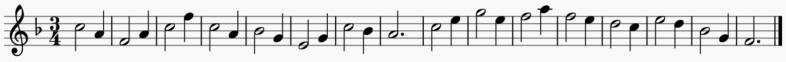
Notation of melody B (1).